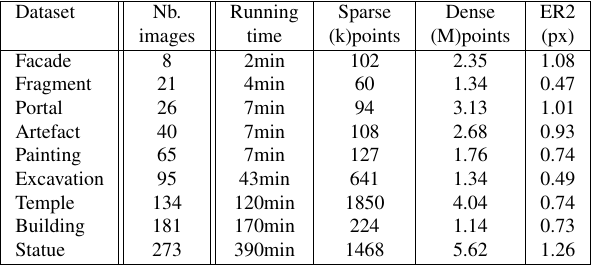
Table 1: Composition and results of initial data sets extracted from the global benchmarking.